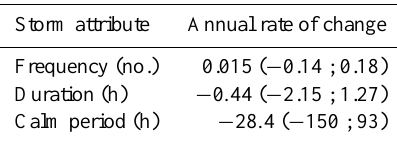
Table 5. Annual rate of change of storm attributes with 95% confi- dence bounds.